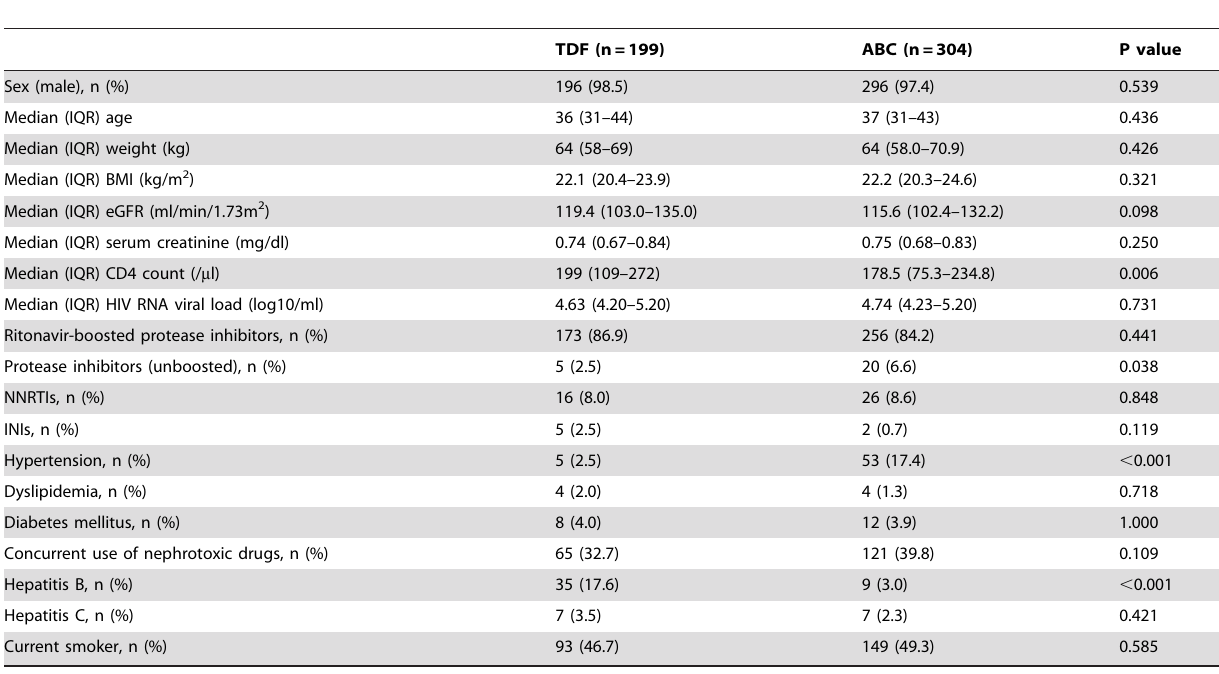
Table 1. Baseline demographics and laboratory data of patients who received tenofovir- and abacavir-based antiretroviral therapy